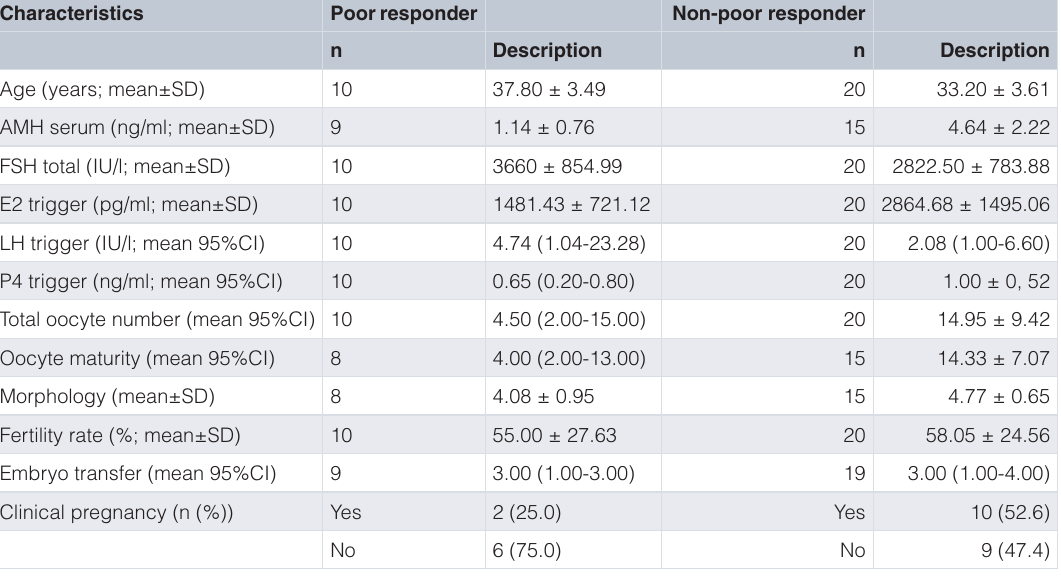
Table 3. Patient characteristics of poor and non-poor responders to IVF in a group of patients in Jakarta.